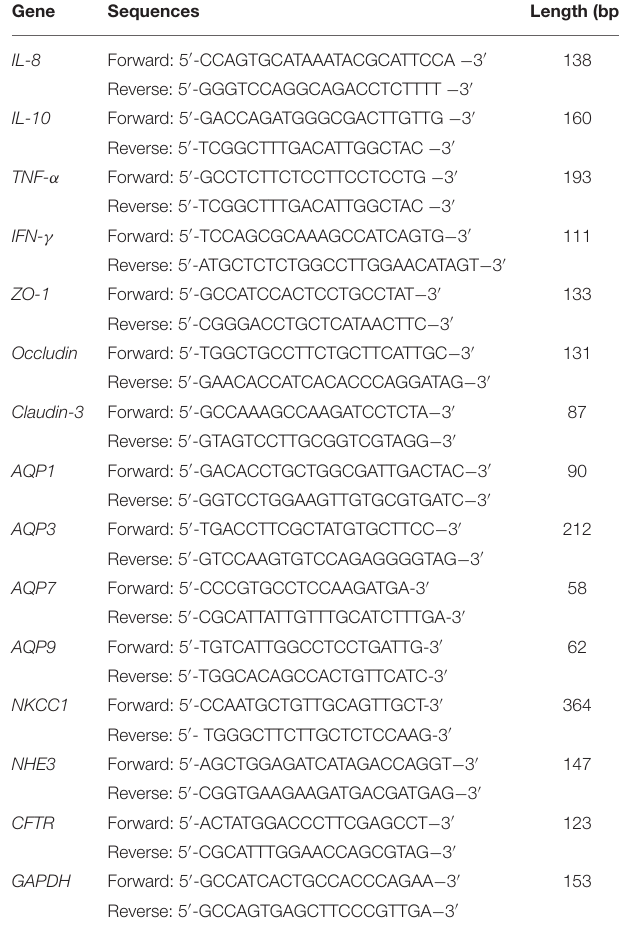
TABLE 3 | Primers for real-time